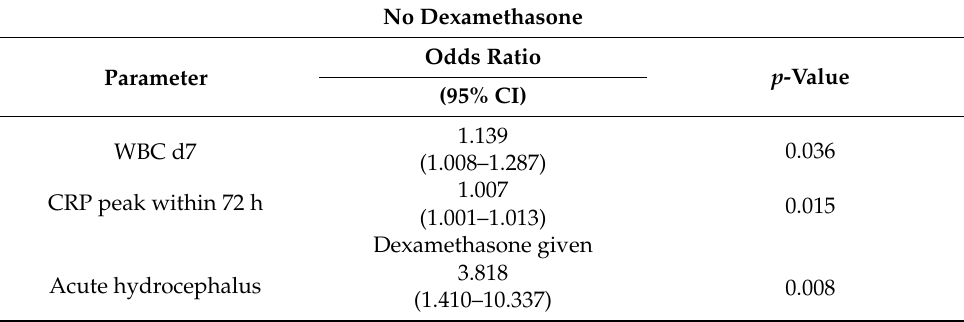
Table 4. Multivariate analysis for the development of shunt-dependent hydrocephalus (significant parameters).